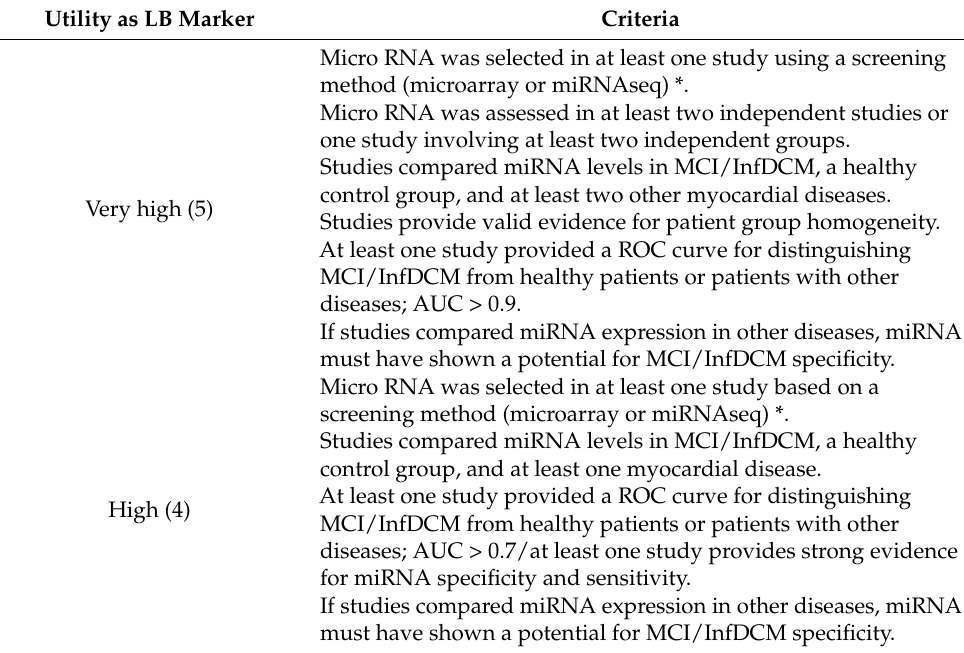
Table 4. miRNA screening